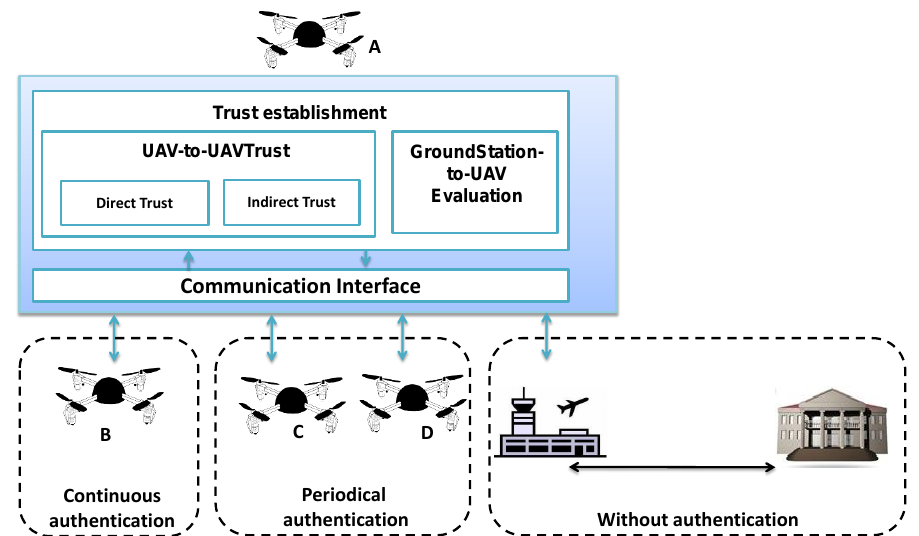
Figure 7. Overview of the proposed Trust-based data authentication